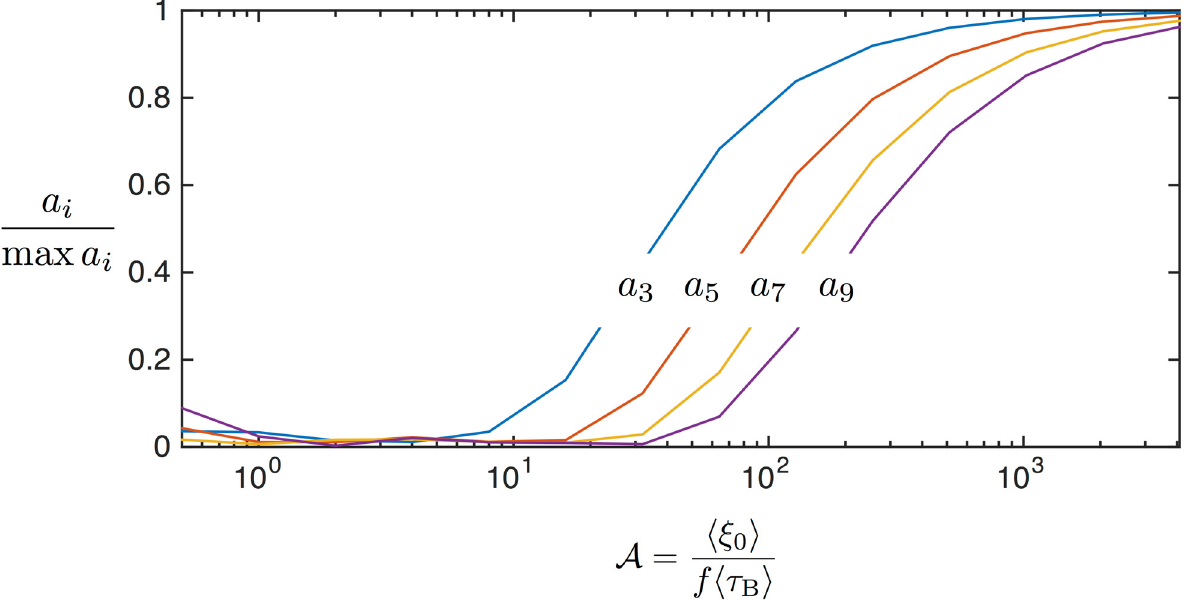
Fig 6. (Color online) Simulated magnetization harmonics are shown for values of A . The shapes of the curves are sigmoidal, showing that as the fi eld amplitude is increased the magnetization saturation increases, and each harmonic saturates. The region of each harmonic containing the steepest slope provides the largest changes in the harmonic for small changes in the master variable time, i.e., the optimal sensitivity range for MSB